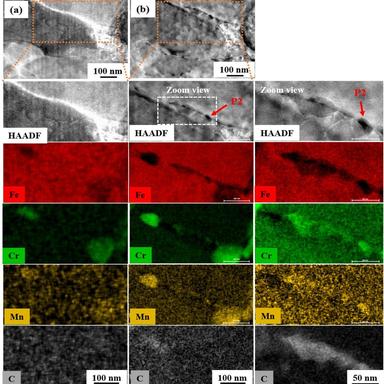
STEM-HAADF micrographs and corresponding elemental maps of Fe, Cr, Mn and C were collected at the same area of HT9 (a) before and (b) after ion irradiation to 20 dpa at 440 °C. The zoom view of panel (b) highlights the formation of (Cr, Mn)-rich carbides at the grain boundary. One of these carbides (labeled as P2) is further observed in. (two columns wide).